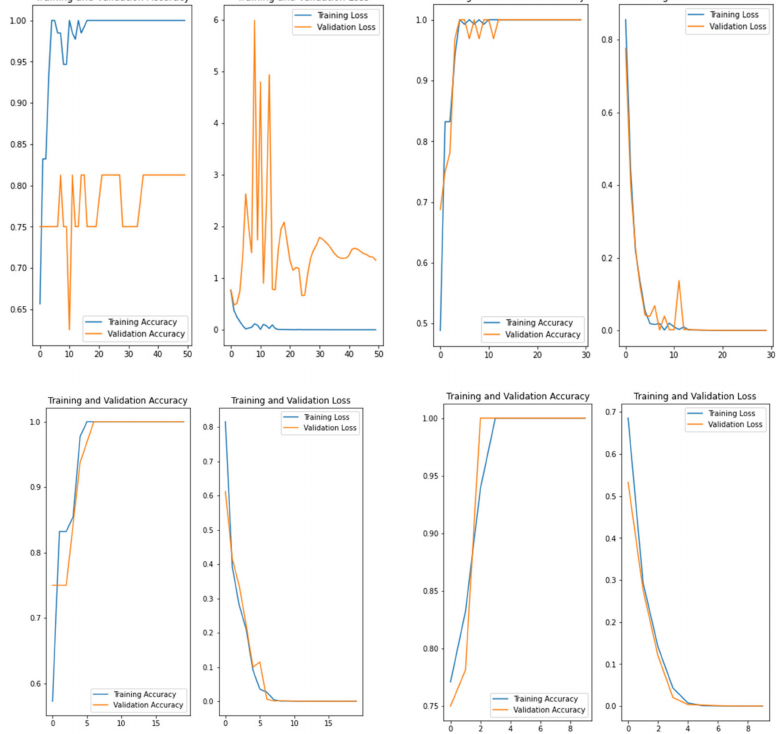
Figure 5. Illustration of model accuracy rate for 50, 30, 20, and 10 epochs for DB2 dataset acquired using an optical sensor “U.are.U